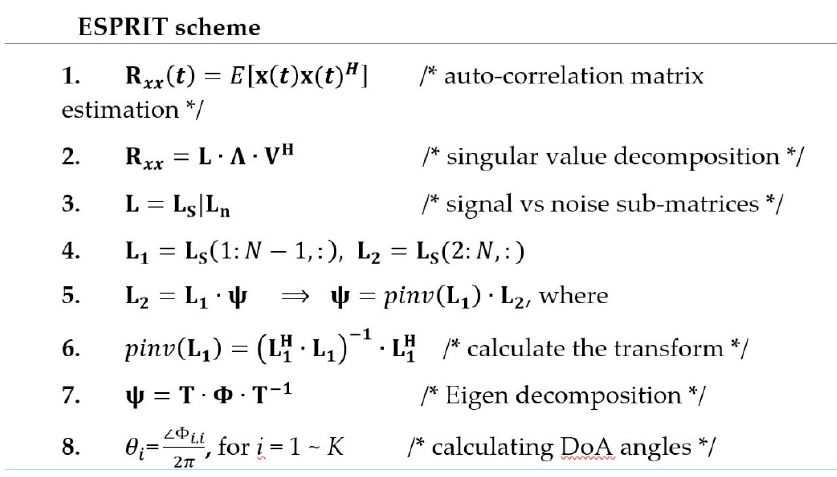
Figure 1. Pseudo code of the Estimation of Signal Parameters Via Rotational Invariance Techniques (ESPRIT) Direction of Arrival (DoA) estimation algorithm.